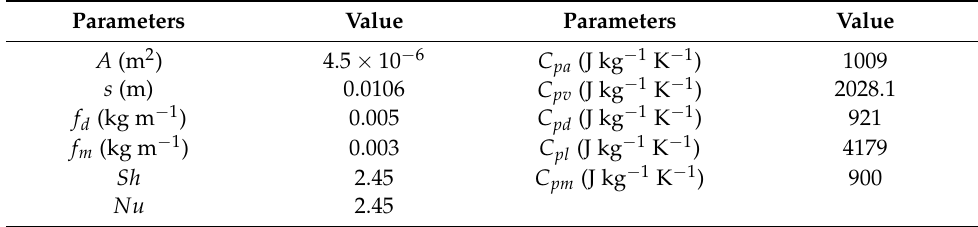
Table 2. The parameters used in the numerical calculation of the desiccant wheel. Parameters